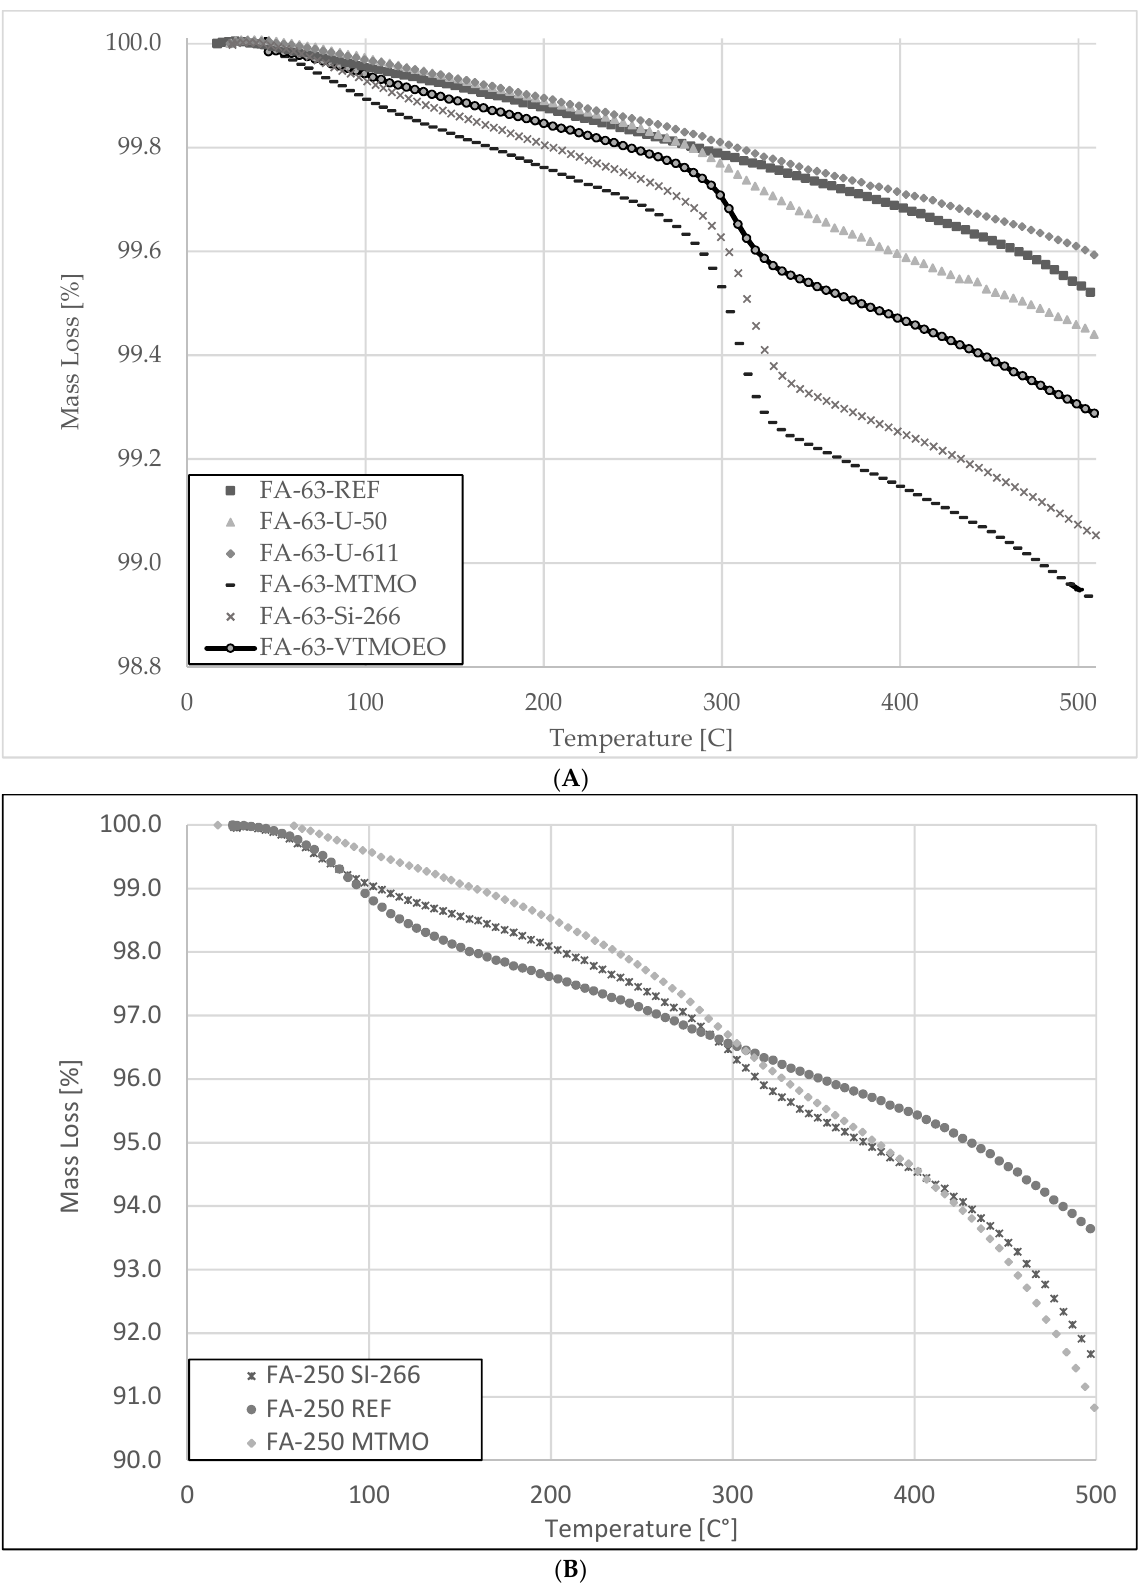
Figure 4. Thermogravimetric analysis (TGA) of the unmodified and silane modified fly ash: ( A ) fraction < 0.063 mm; ( B ) 0.125 mm < fraction < 0.250 mm. The quantity of modifying agents at the surface of the FA fraction (A) particles was approximately 0.376% for MTMO silane, 0.253% for Si-266 silane, 0.199% for VTMOEO